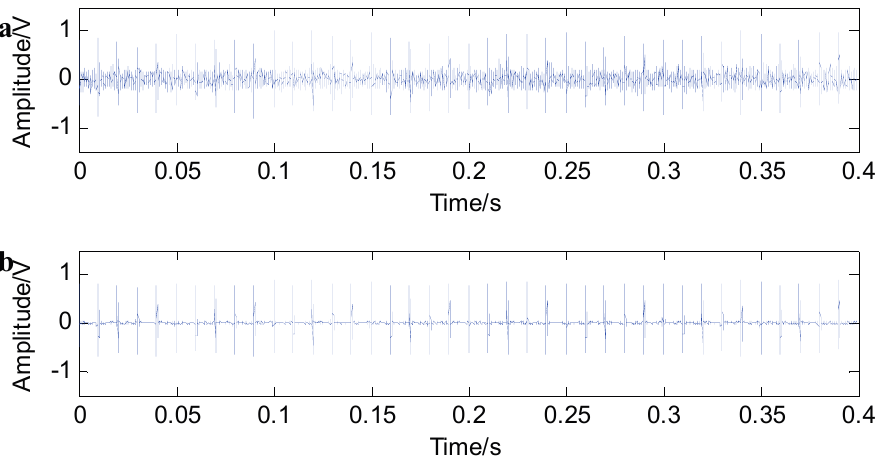
Figure 5. Simulated fault signal of rolling bearing with SNR = 20 dB ( a ); and filtered signal with fast NL-Means ( b